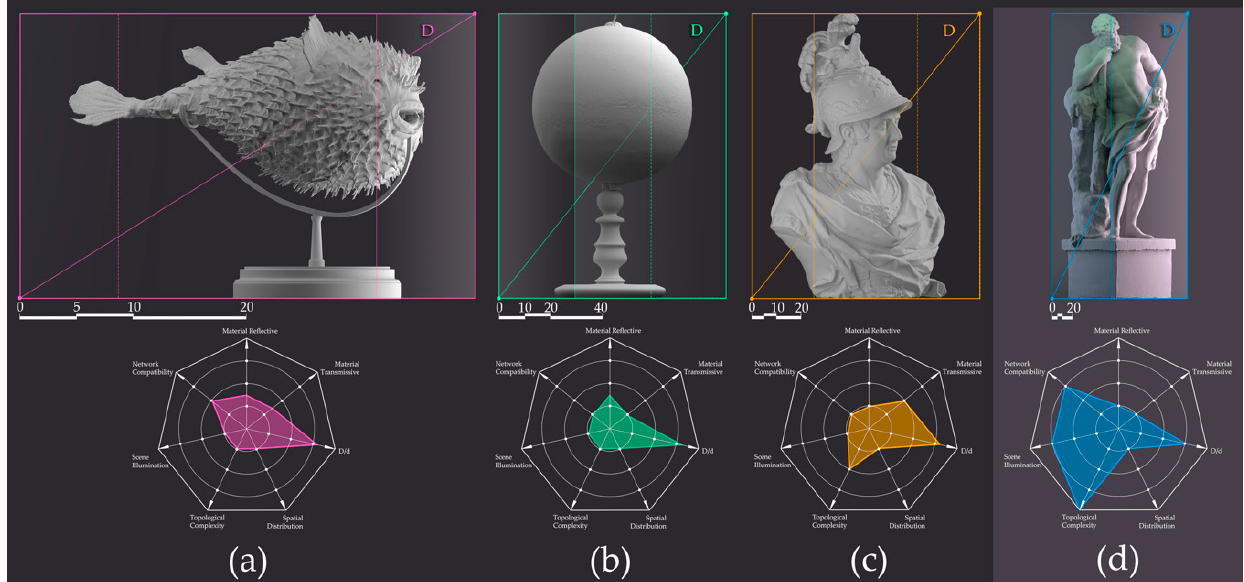
Figure 20. Subjects for the testing phase: ( a ) Hercules; ( b ) Porcupinefish; ( c ) Horn d’Arturo Globe; ( d ) Marsili bust. Each case study is represented with its bounding box and diagonal D (see intrinsic feature). The diagrams at the bottom represent the general features of each object (see Figure 21).